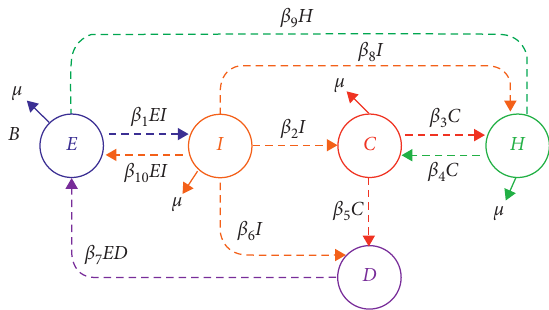
Figure 1: Transmission dynamics of Table 1: Parameters used in the model.